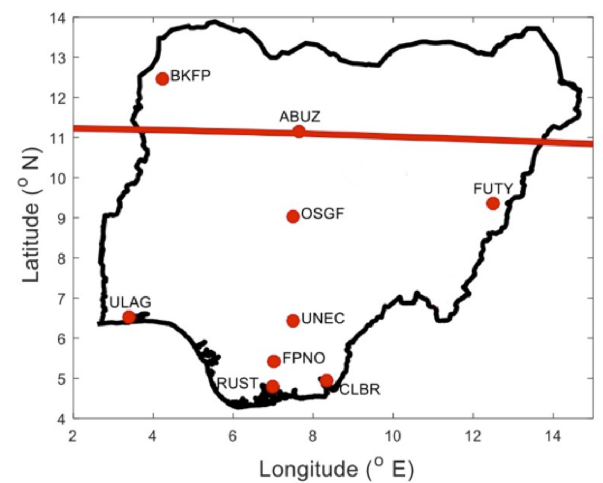
Figure 1. The distribution of the NIGNET GPS stations used for the study. The axes shows the geographical coordinates in degrees; the red solid line crossing near ABUZ is the magnetic